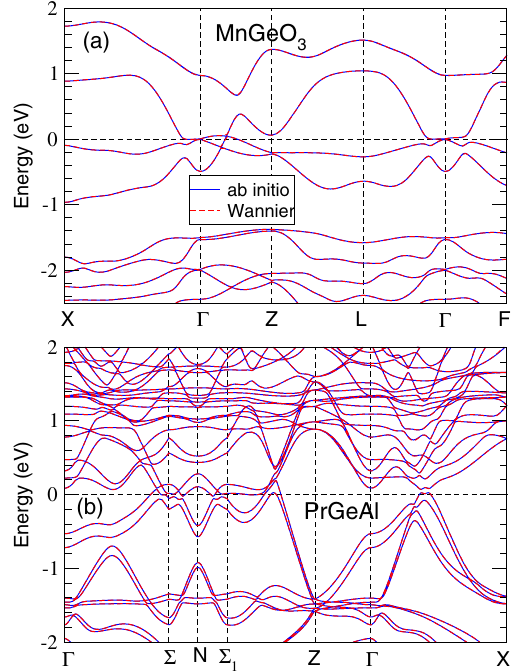
FIG. 9. Crystal and magnetic structures of (a) MnGeO 3 and (b) PrGeAl. The associated Brillouin zones are shown in panels (c) and (d), respectively.